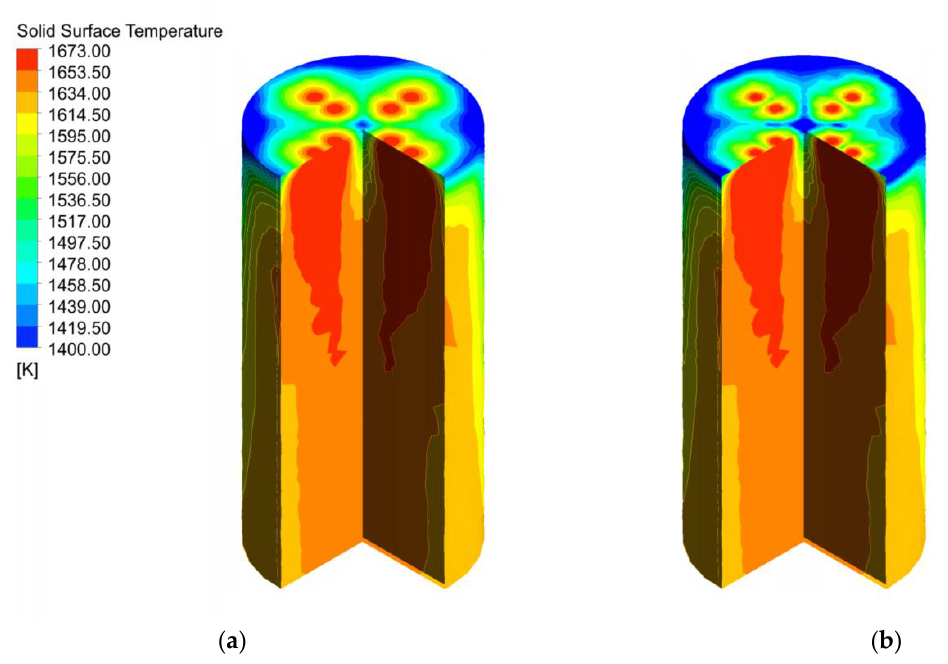
Figure 12. Solid temperature field in the calcination zone at 40 mm and 120 mm. ( a ) Solid surface temperature of 40 mm; ( b ) Solid surface temperature of 120 mm.